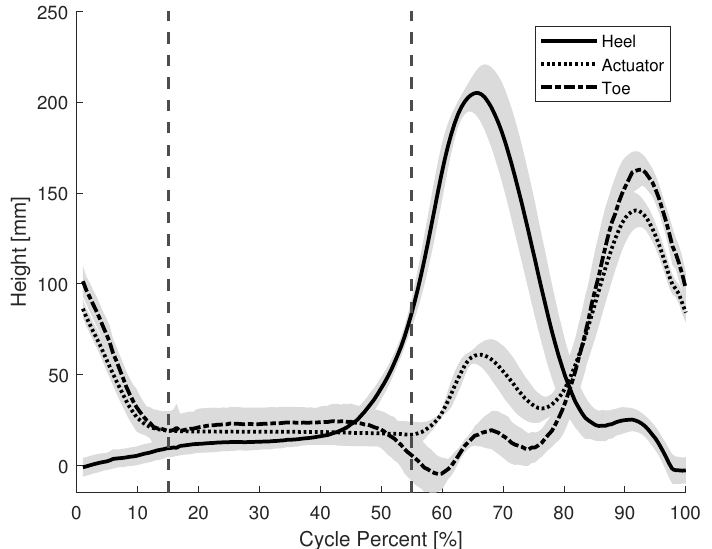
Figure 7. Brake activation timing during the gait of a healthy